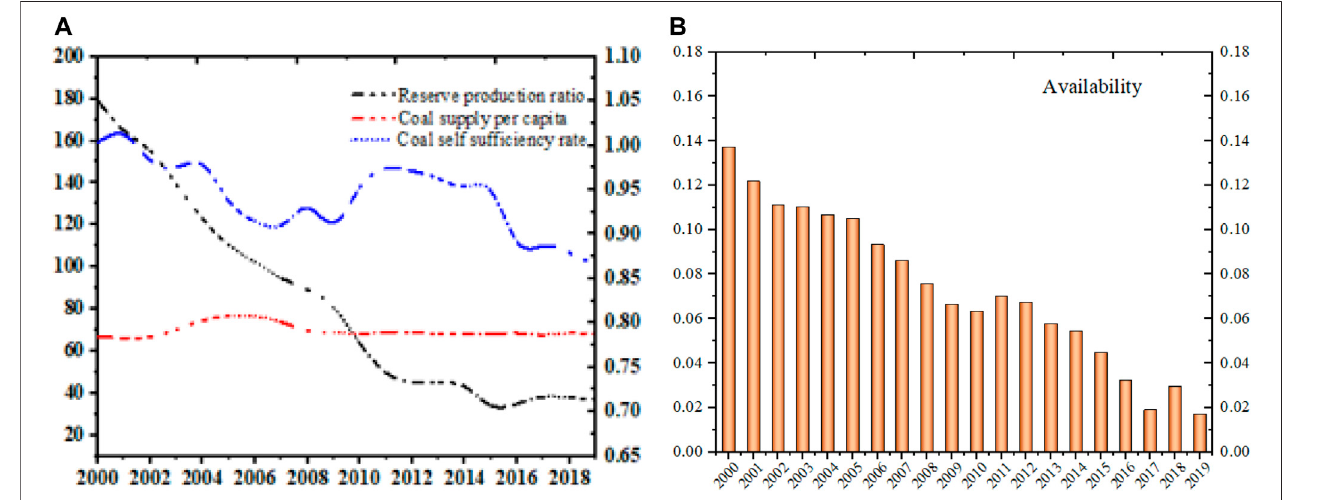
FIGURE 4 | Availability results from 2000 to 2019: (A) indicator value; (B) dimension